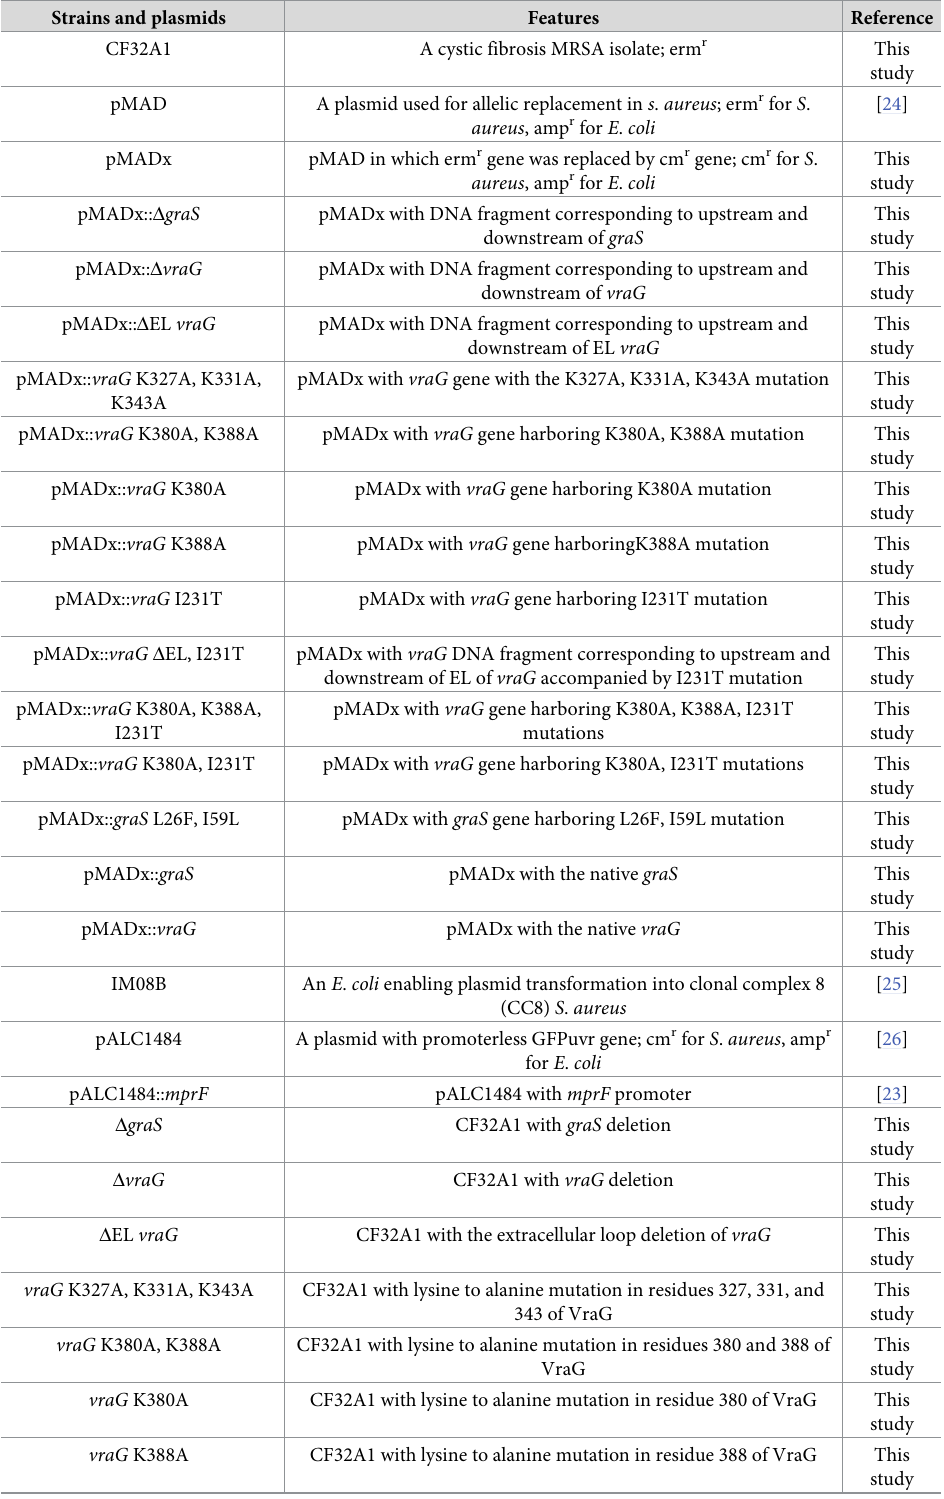
Table 1. Strains and plasmids. Strains and plasmids